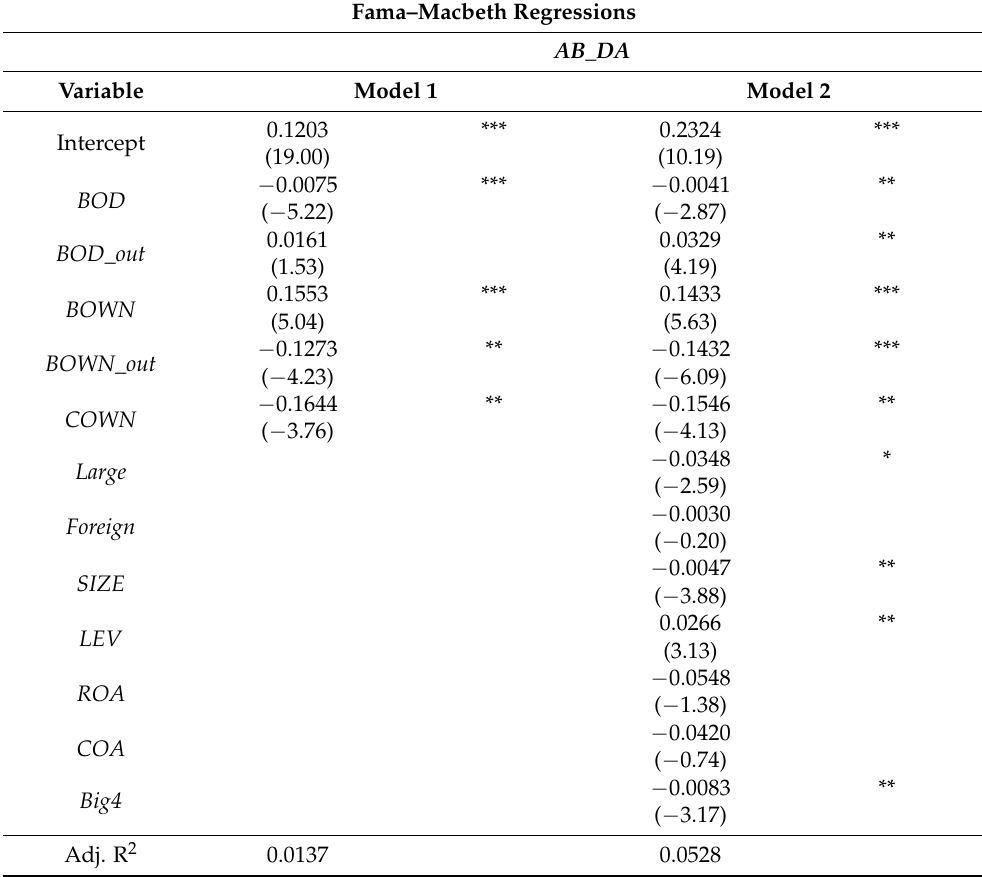
Table 3. Board characteristics and earnings